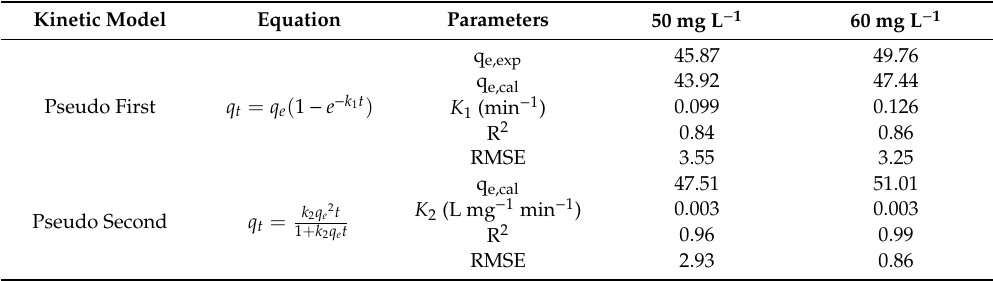
Table 4. Kinetics parameters obtained for the adsorption reaction of CV (50 and 60 mg L − 1 ), with AS-g-PAni@MS nanocomposite at 333 K.